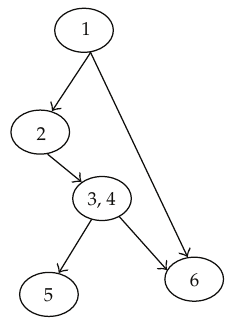
Figure 2: Level two Bayesian